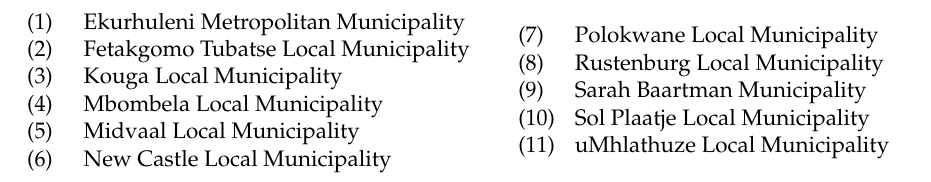
Table 2. Sampled municipalities (representing target groups 2 and